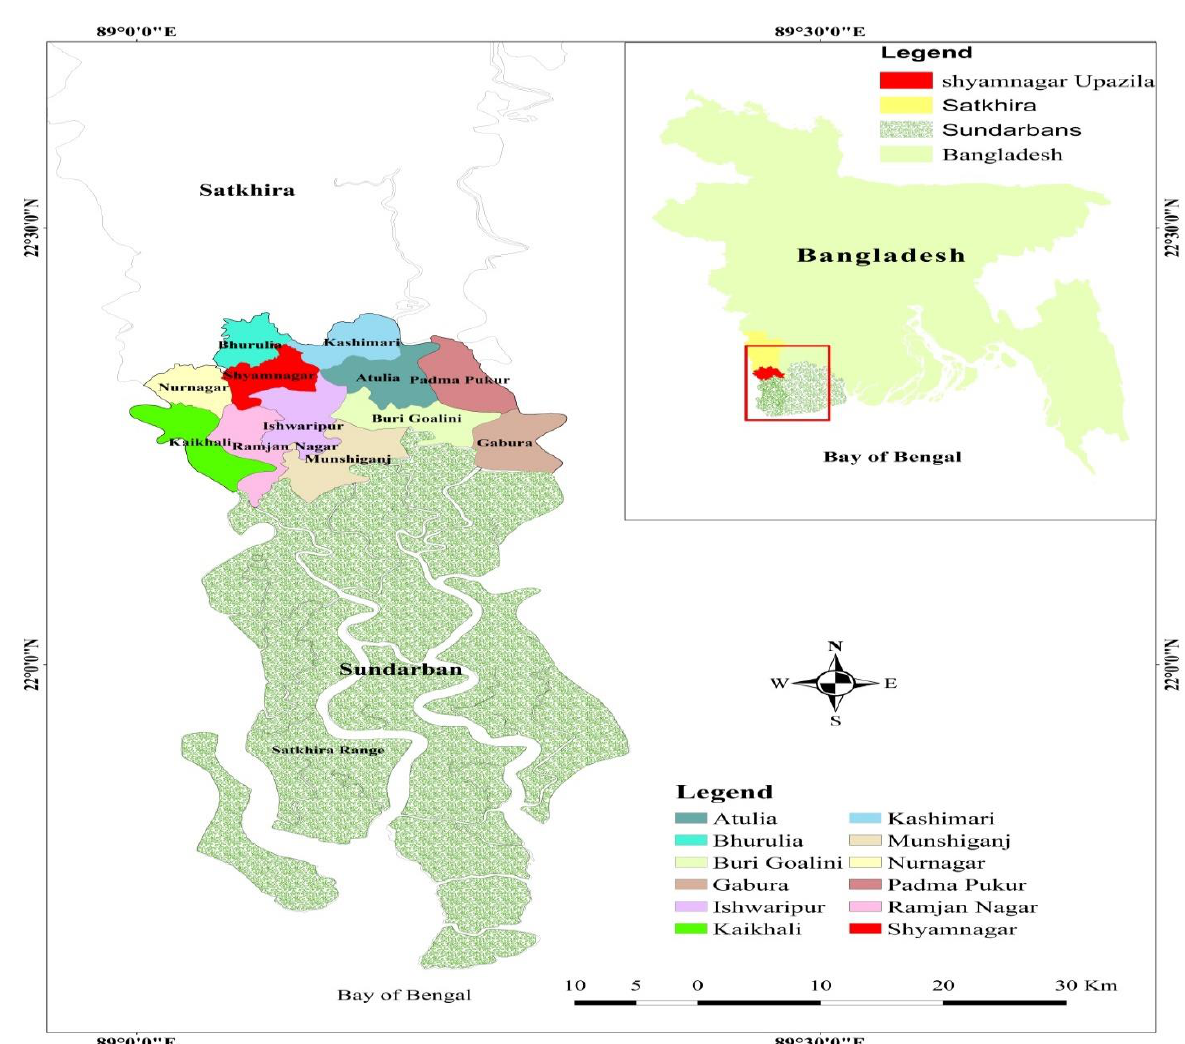
Figure 1. 12 Unions under Shyamnagar Upazila, adjacent to the Bay of Bengal.